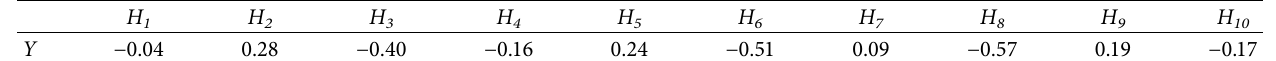
Table 3: Connection weights of the hidden layer and the output layer.